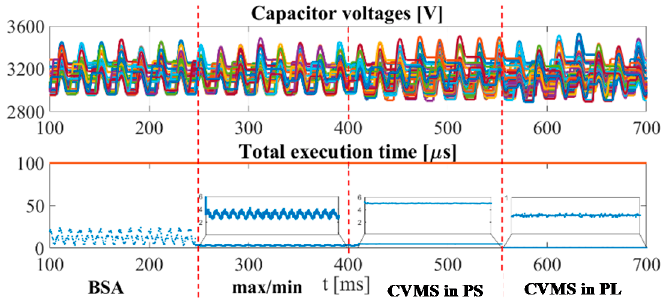
Figure 13. Capacitor voltages of the upper arm and execution time for the bubble sorting algorithm, the max/min approach, the CVMS implemented in the processor system and in the programmable logic (Hardware-In-the-Loop (HIL) results).